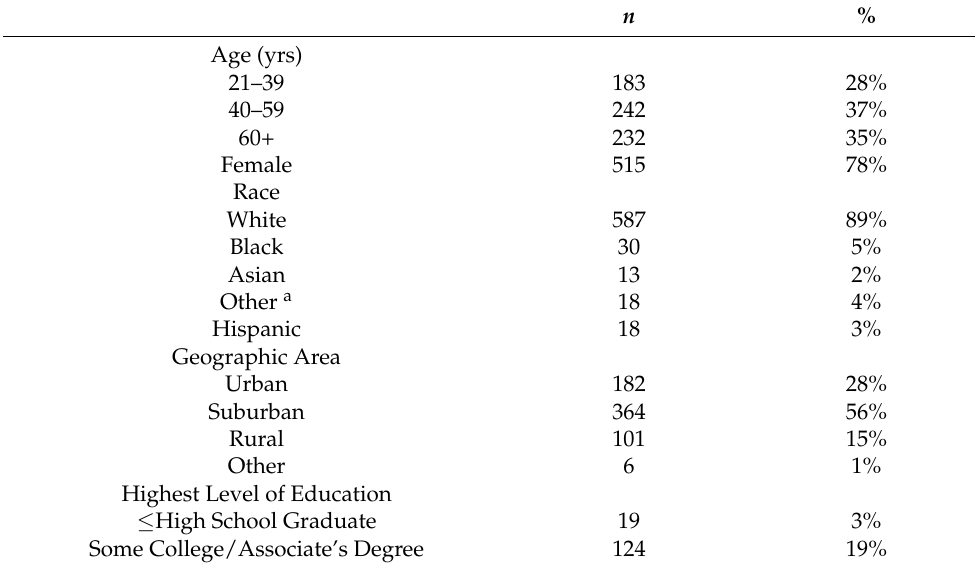
Table 1. Respondent characteristics ( n =